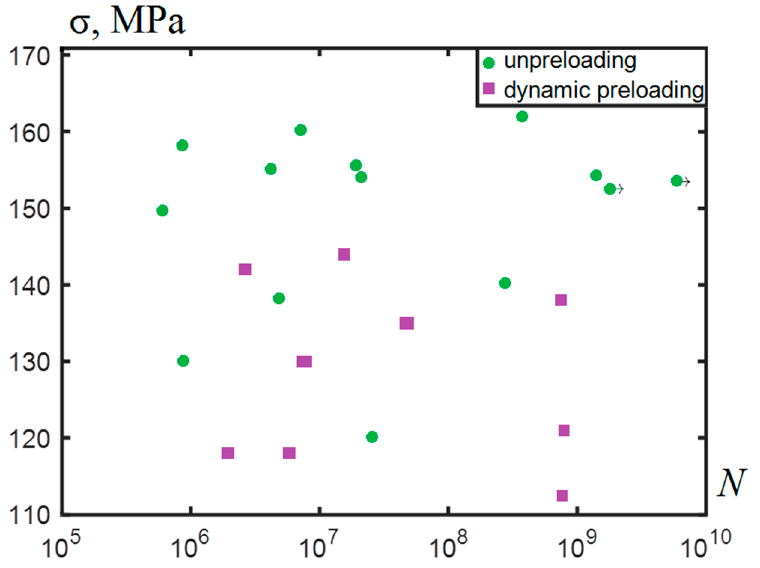
Figure 3. The S–N curve (Stress in MPa) in the case of dynamic preloading and in the absence of preloading for the AlMg6 alloy.